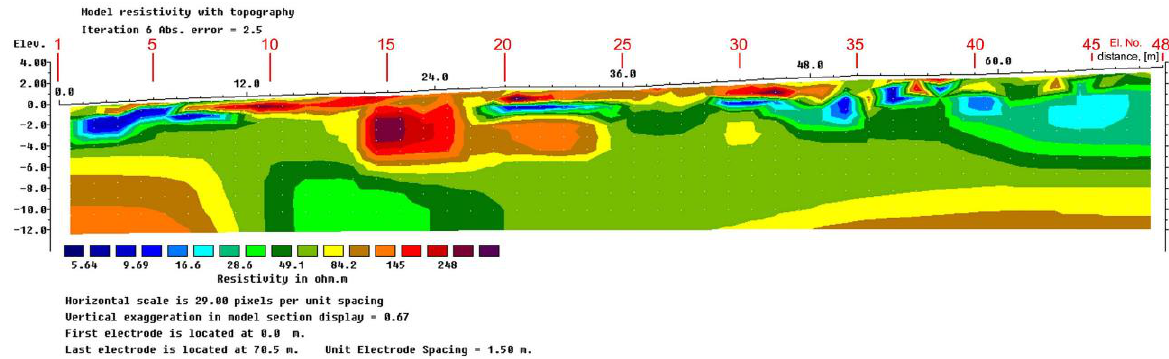
Figure 14. The distribution of the apparent resistivity based on the measurement with the Dipole–Dipole array.